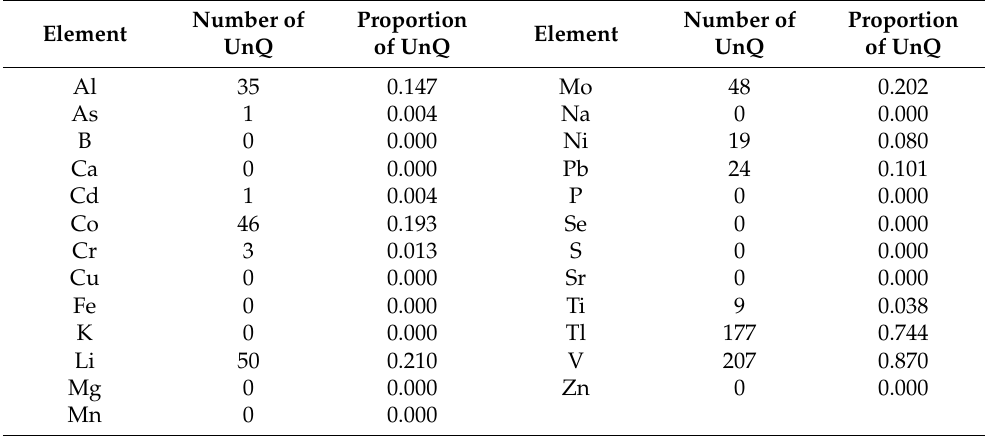
Table 2. Number of unquantifiable (UnQ) samples for the 25 analyzed elements in 238 blood samples of olive ridley sea turtles nesting in Oaxaca, Mexico [9].